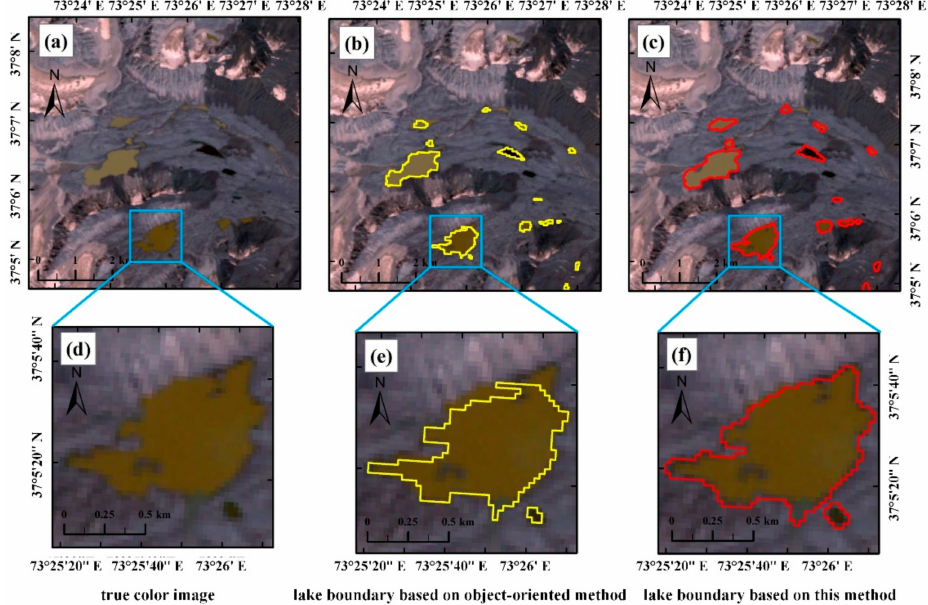
Figure 4. Lake extraction results based on different methods: ( a , d ) True color image, ( b , e ) lake extraction results based on object-oriented method, ( c , f ) this method.